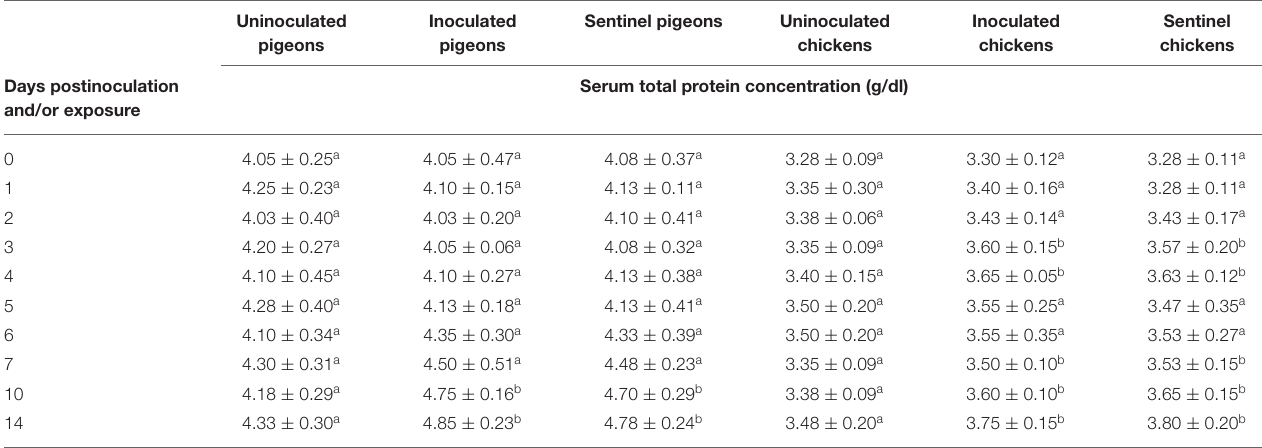
Uninoculated Inoculated Sentinel pigeons Uninoculated pigeons pigeons